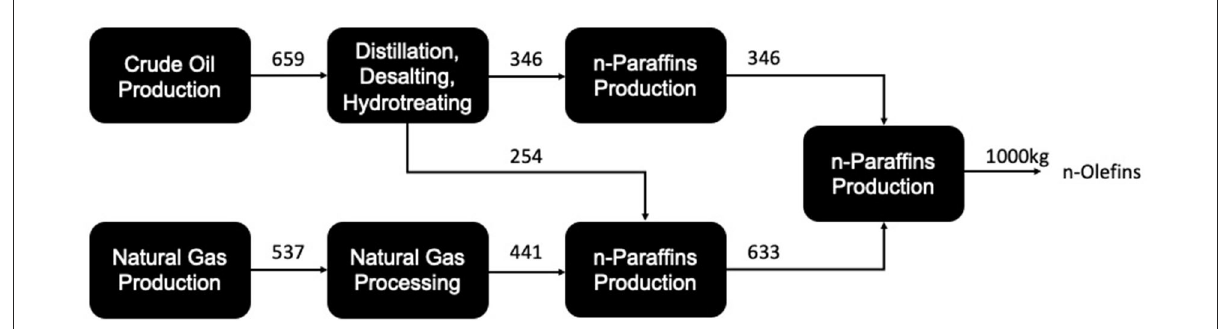
FIGURE5 The production of olefins from fossil-based sources (process loss streams not included) (after Franke et al., 1995).